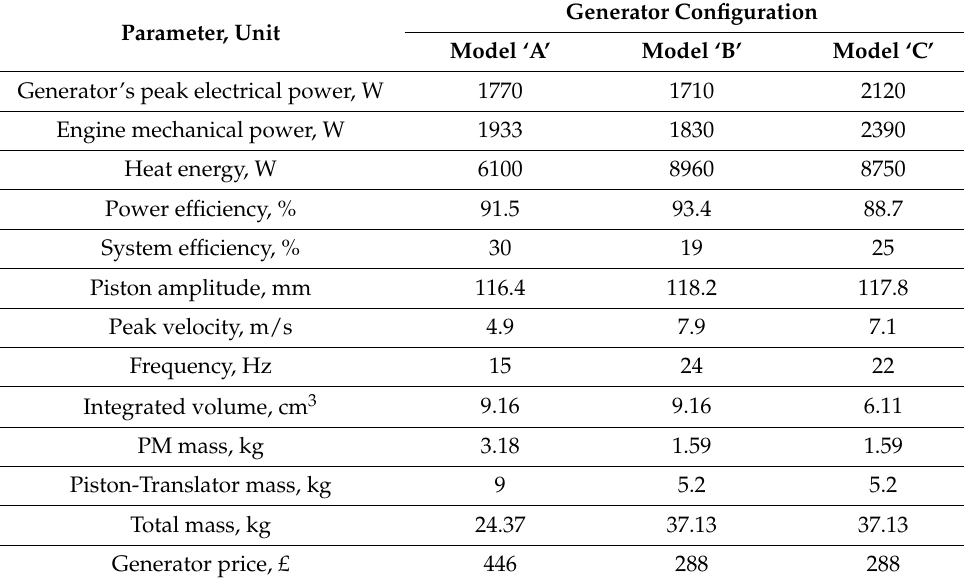
Table 2. Parameter comparison of the proposed generators.